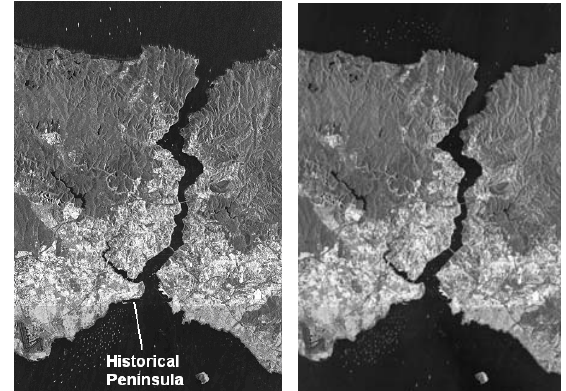
Figure 3. TSX SM Istanbul SAR image-pair